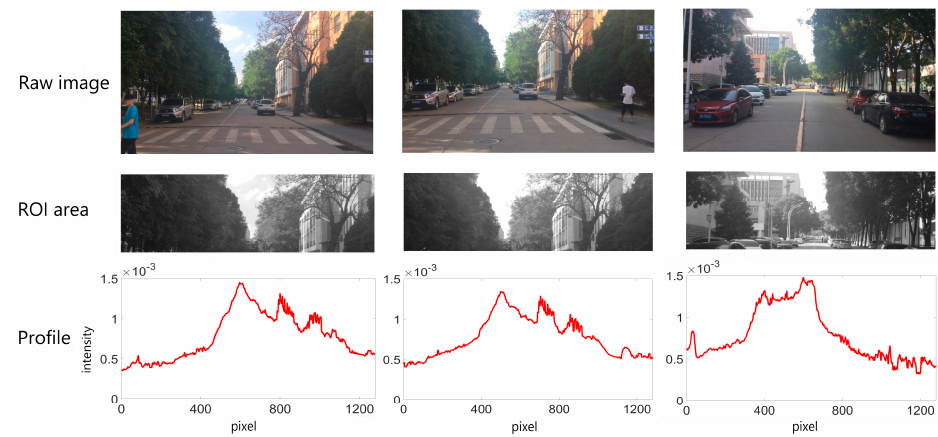
Figure 5. Raw image, region of interest (ROI) area and the scanline profile of the image.